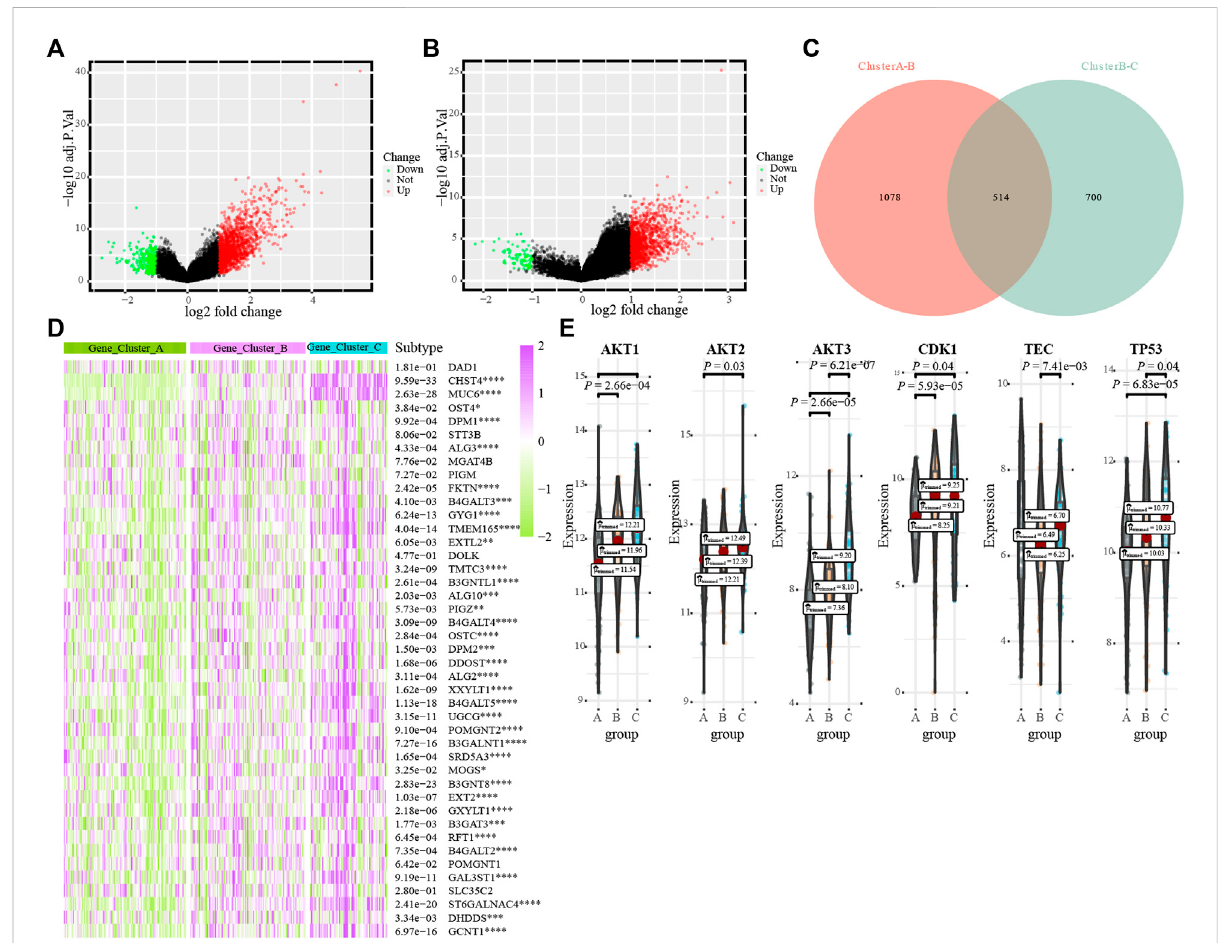
FIGURE 5 The transcriptome characterization of the glycosylation-related models. (A) . Distribution of differentially expressed genes between Cluster_ A and Cluster_B; (B) . Distribution of differentially expressed genes between Cluster_B and Cluster_C; (C) . Venn diagrams; (D) . The differential expression of 43 glycosylation regulators in different glycosylation-related subtypes; (E) . G2M_CHECKPOINT and PI3K_AKT_MTOR_SIGNALING in different glycosylation